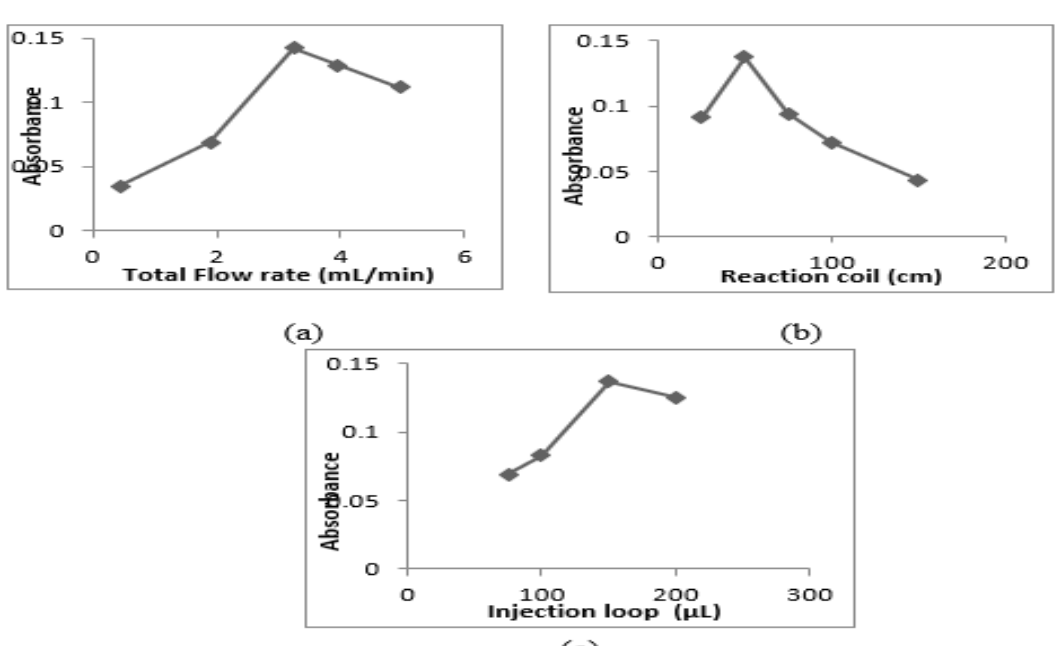
Figure 6 . (a) The effect of total flow rate on reaction absorbance, (b) Effect of reaction coil of the absorbance, (c) Effect of the injection